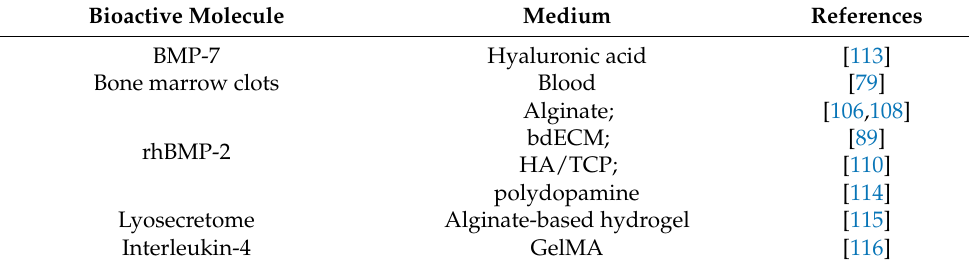
Table 5. Bioactive molecule inclusion in PCL-based scaffolds for